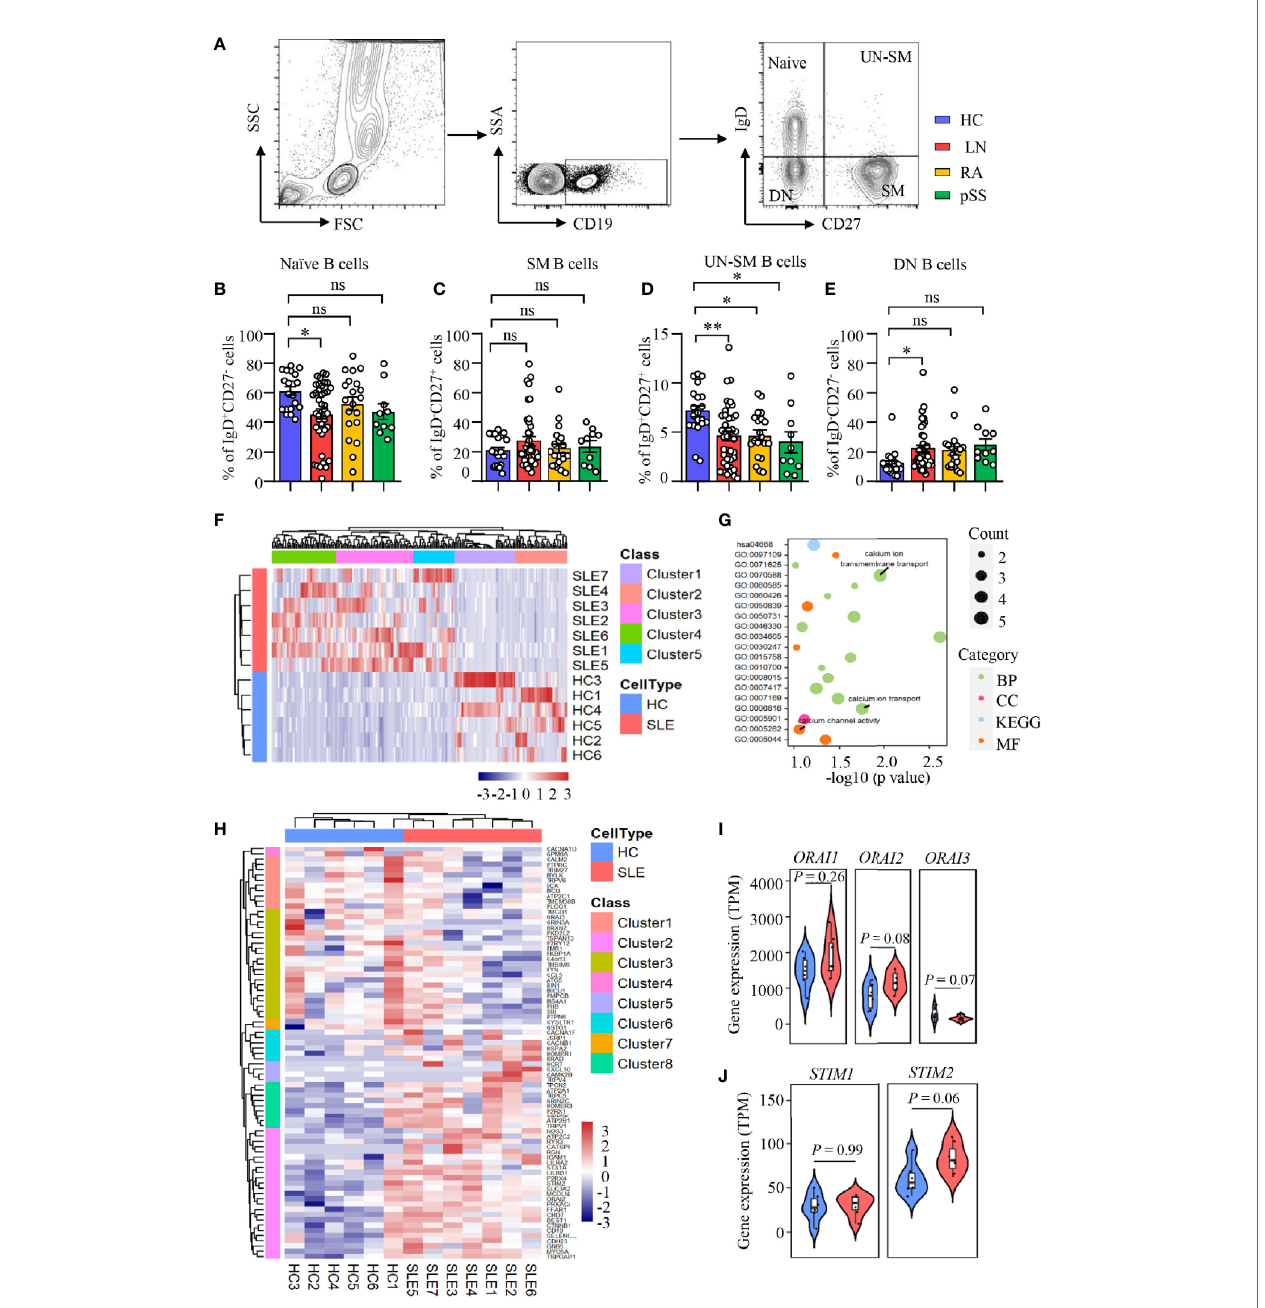
FIGURE 1 | Enriched calcium signaling in B cells from patients with LN. (A – E) PBMCs were isolated from patients with lupus nephritis (LN), rheumatoid arthritis (RA), primary Sjogren ’ s syndrome (pSS), or healthy controls (HC). Naive B cells (CD19 + IgD + CD27 − ), switched memory B cells (CD19 + IgD − CD27 + , SM), unswitched memory B cells (CD19 + IgD + CD27 + , UN-SM), and double-negative B cells (CD19 + IgD − CD27 − , DN) were analyzed by fl ow cytometry. (A) Gating strategy. Percentages of (B) naive B cells, (C) SM B cells, (D) UNSM B cells, and (E) DN B cells are summarized in dot plot with bar plot. LN = 40, RA = 20, pSS = 10, HC = 20. (F – J) RNA-seq data of B cell puri fi ed from peripheral blood of patients with systemic lupus erythematosus (SLE) or HC were acquired from the database (GSE118254) for gene expression and bioinformatics analysis. (F) Gene expression clustered heatmap represents the scaled average expression of top 200 DEGs. (G) Bubble plot of GO and KEGG analysis. The number of DEGs enriched in different terms are indicated by size of dots. (H) Clustered heatmap of the scaled average expression 79 DEGs in three calcium-related GO classes. (I, J) Violin plot of ORAI1, ORAI2, ORAI3, STIM1, and STIM2 expression levels. The upper, median, and lower horizontal lines of white box represent 75th, median, and 25th percentage of the gene expression distribution, respectively. All data are mean ± SEM. *p < 0.05 and **p < 0.01 by one-way ANOVA in Panel (B – E) and Student ’ s t-test in Panels (I, J) ns, not signi fi